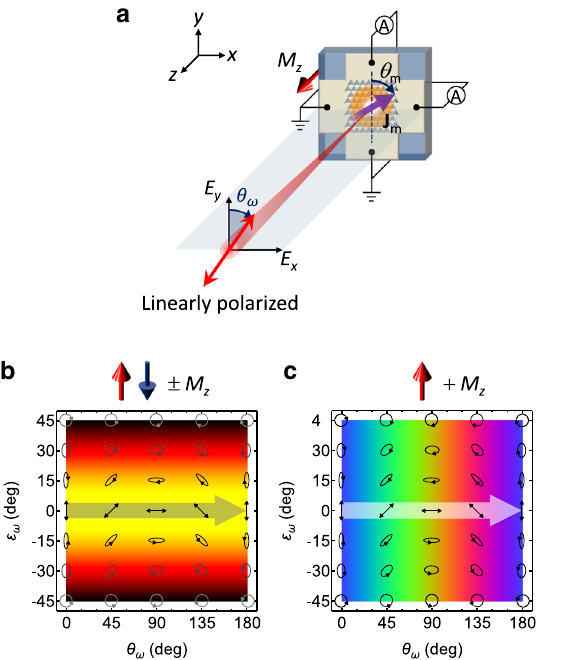
Fig.3|Full-directionalcontrolofspin-drivenphotocurrents.a Schematicofthe experimental setup for measuring zero-bias photocurrents along the x and y directions at normal incidence of continuously rotated linearly polarized 800-nm light. b , c 2D color maps of ( b ) ∣ J m ∣ for± M z and ( c ) θ m for+ M z when linearly polarized light crosses the horizontal directions (marked by thick arrows). d θ ω dependence of J m, x and J m, y , calculated as J m, x = J x ð + M z Þ(cid:2) J x ð(cid:2) M z Þ